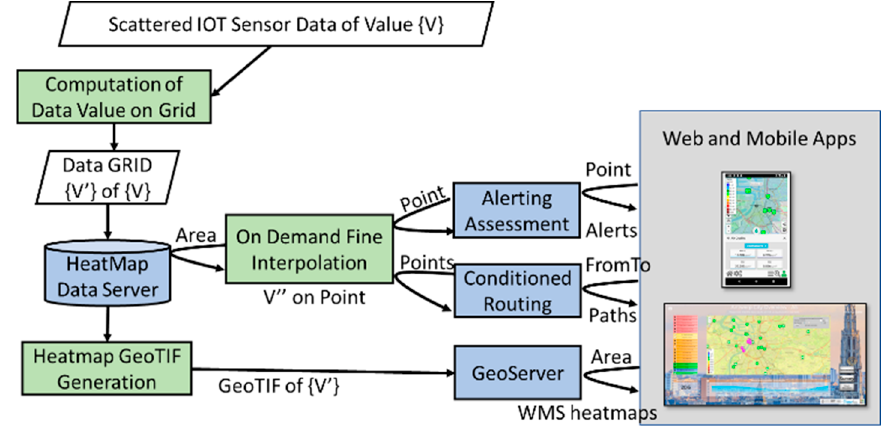
Figure 2. Workflow for the data computation vs. services. Green blocks are implemented as IoT Applications, cyan are tools which expose services via Smart City Application